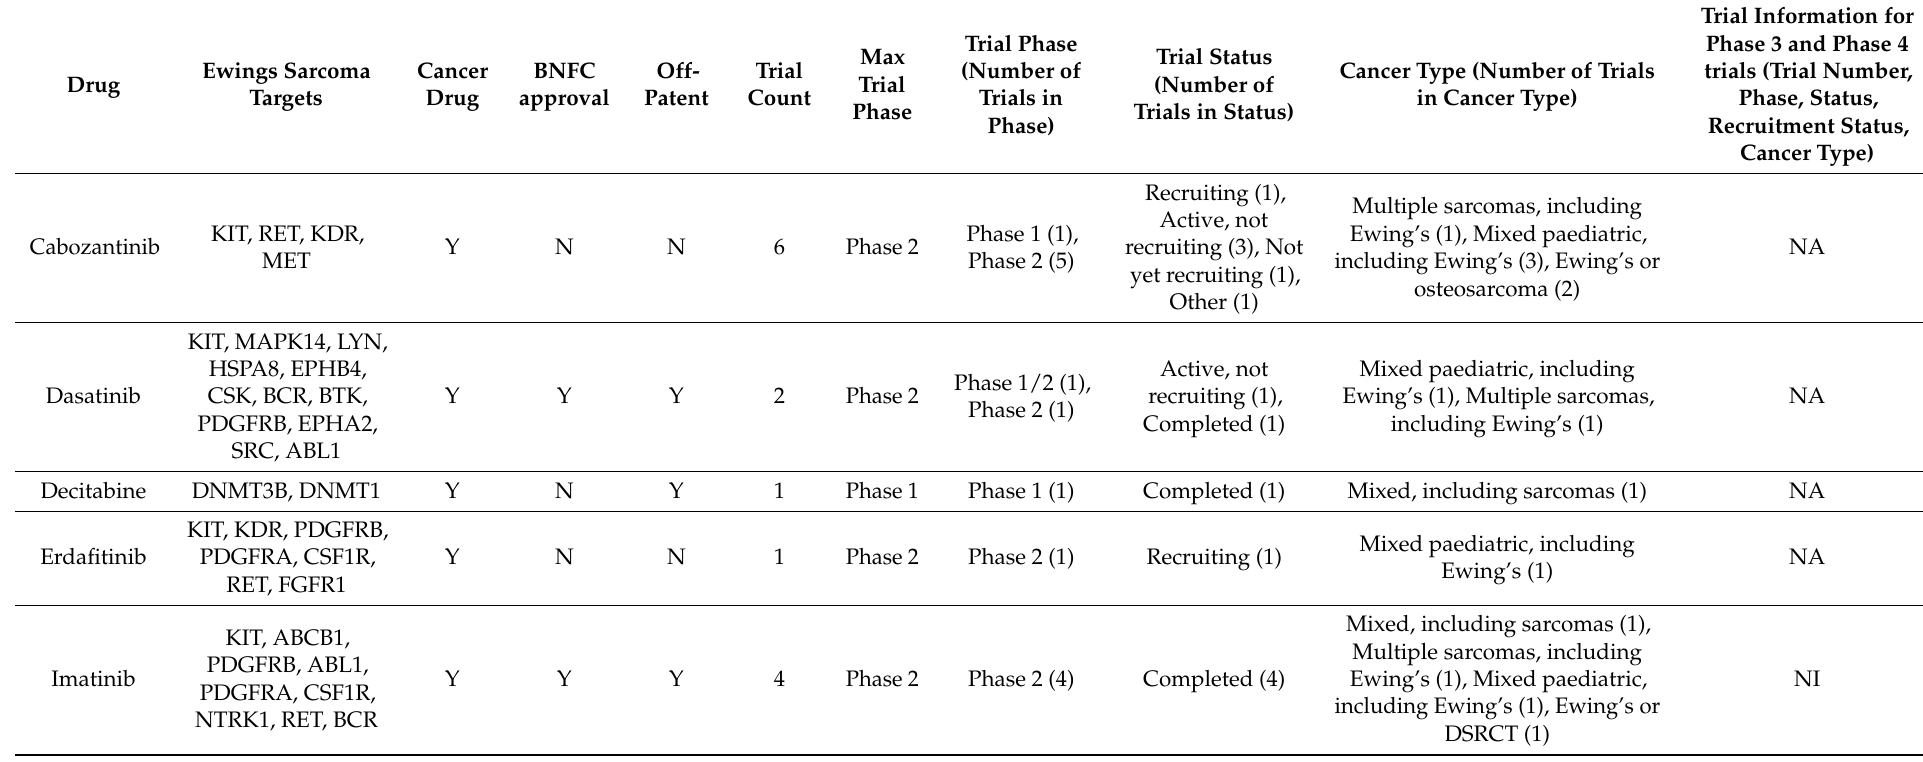
Table 2. Drugs directed against the shared stemness and chemoresistance therapeutic targets. Drugs directed against the shared ES stemness and chemoresistance targets that have been used in human clinical trials, identified using our in-house pipeline. Drug names, direct molecular targets, whether the drug has been previously used in the treatment of cancer patients and is on- or off-patent are shown. The number, trial phase and status, cancer type and detailed trial information of clinical trials are listed. NA = no phase 3 or phase 4 trials recorded for the drug. BNFC = British National Formulary- Children, a directory or all drugs approved for use in children. Y = yes, N = no. * = direct ES targets of fostamatinib (KIT, STK10, SRC, SIK1, RPS6KA1, ROCK2, RET, PTK2B, PTK2, PRKG2, PRKCD,